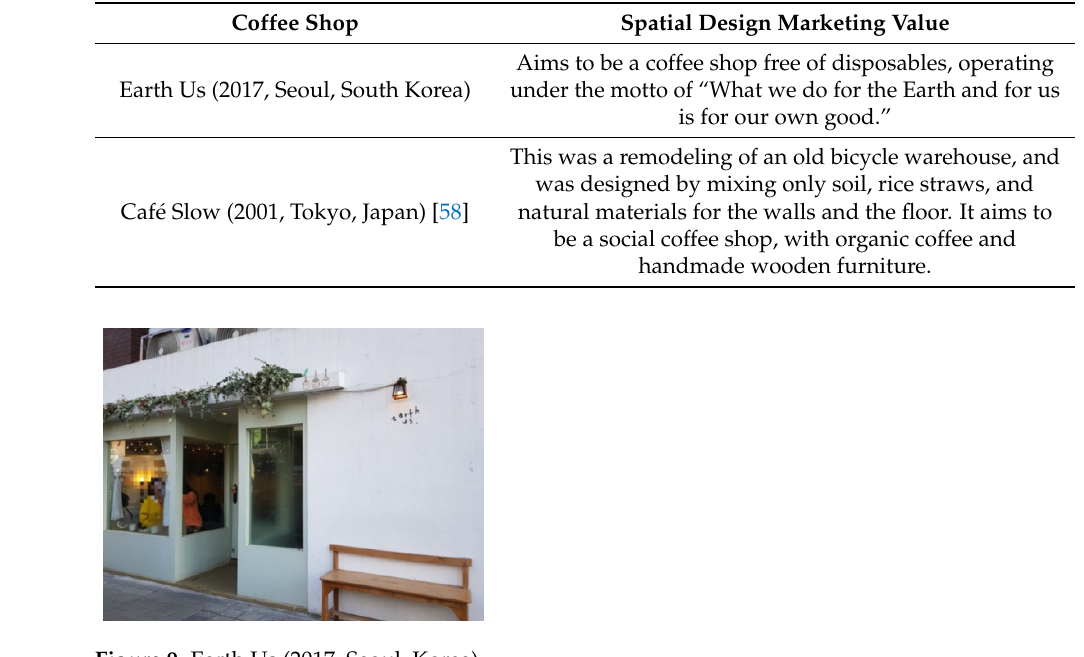
Figure 9. Earth Us (2017, Seoul,